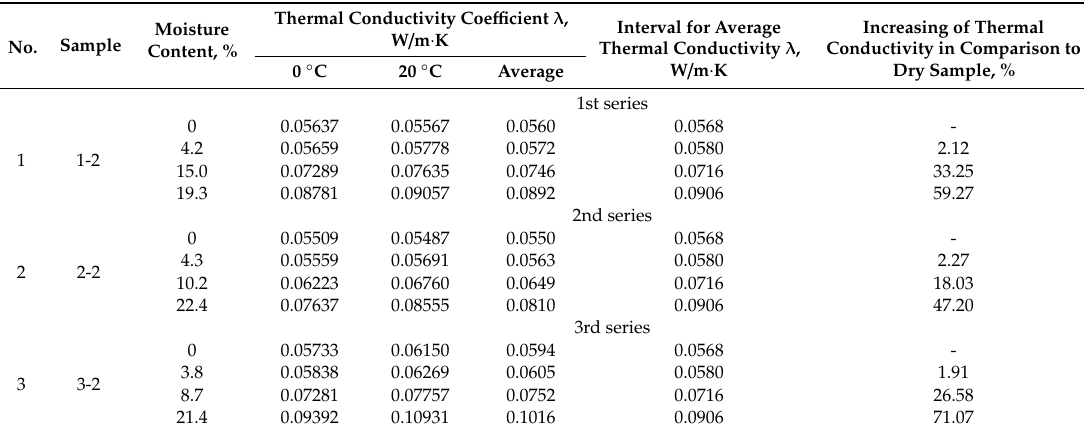
Figure 3. Thermal conductivity measurements of the samples. Table 4. Thermal conductivity coefficient depending on the humidity.